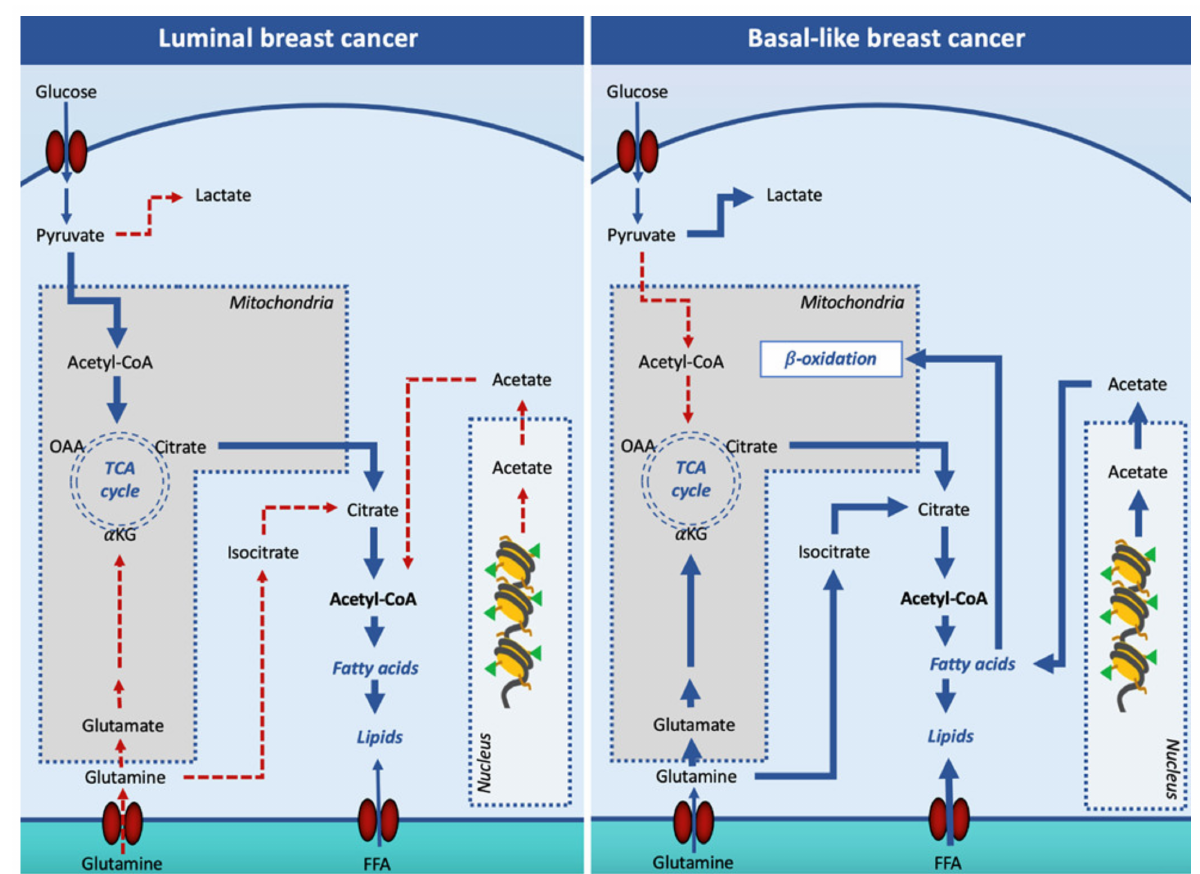
Figure 2. Lipogenesis in luminal and basal-like breast cancer cells. In luminal breast cancer cells, glucose-derived acetyl-CoA is the main source of citrate for the cytosolic synthesis of lipids. In basal-like, pyruvate is mainly converted into lactate in the cytosol, and other substrates such as glutamine and acetate are used to support cell lipid synthesis. Additionally, basal-like breast cancer cells increase free fatty acid entry in the cell to fulfill the β -oxidation pathway. Solid arrows signify the main reaction processes and dotted arrows signify processes with a minor relevance. Abbreviations: FFA, free (non-esterified) fatty acid; OAA, oxaloacetate; α KG, α -ketoglutarate; TCA, tricarboxylic acid